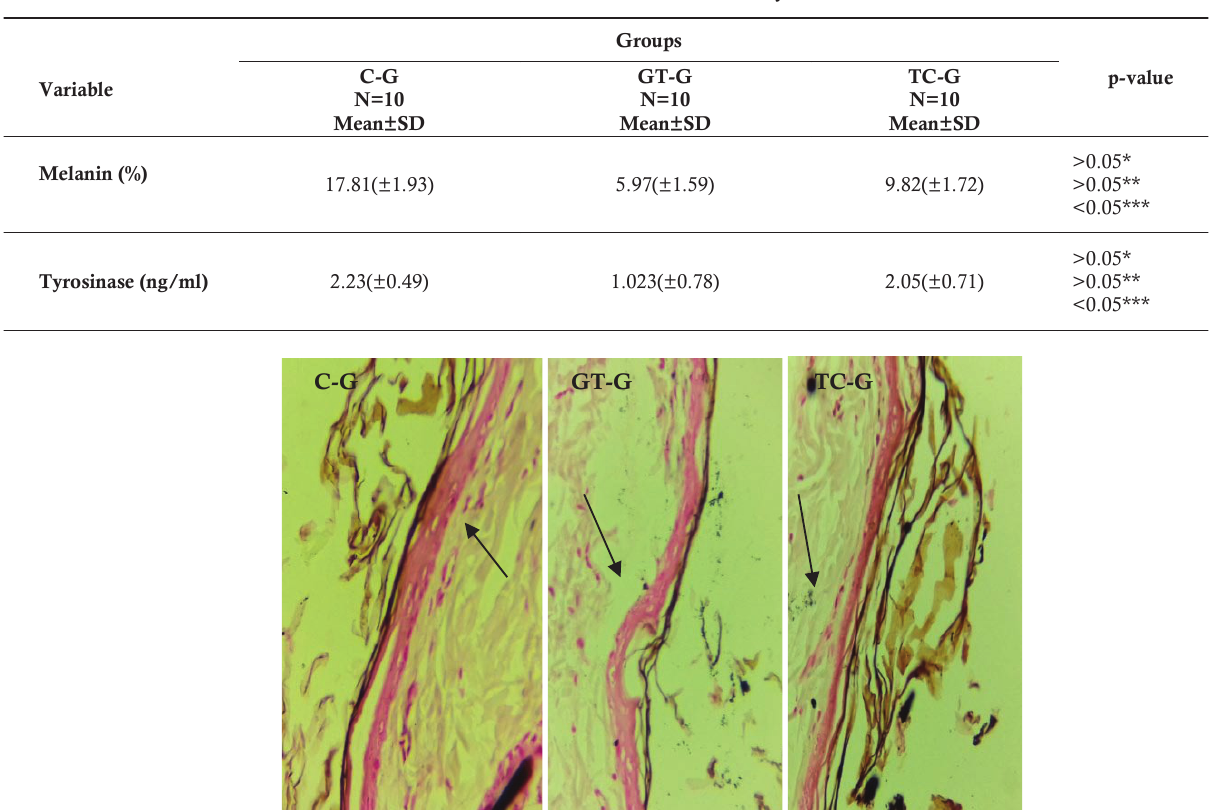
Table 1. Data of Mean Amount of Melanin and Tyrosinase Level